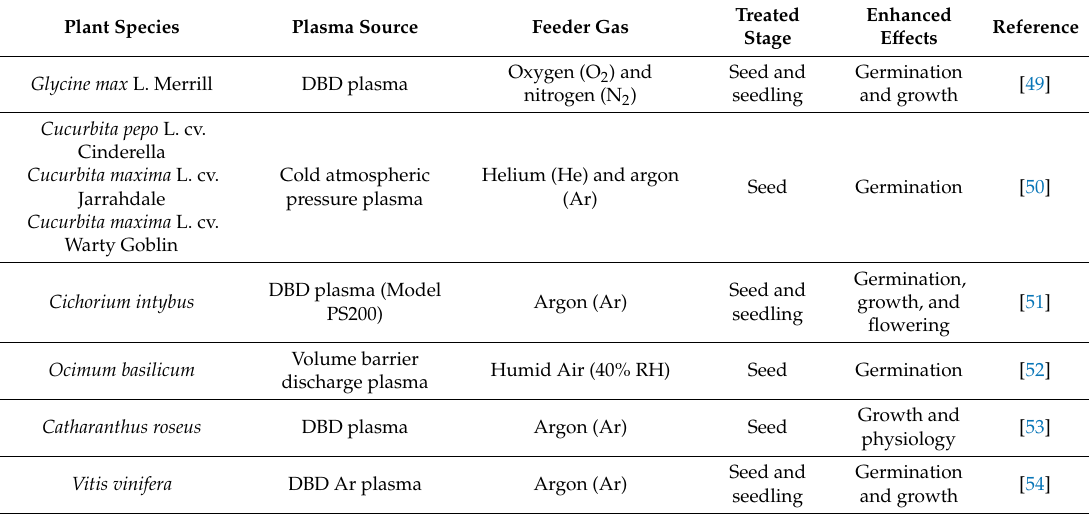
Table 2. E ff ects of plasma treated water / solution on plant germination, growth, and physiology. Plant